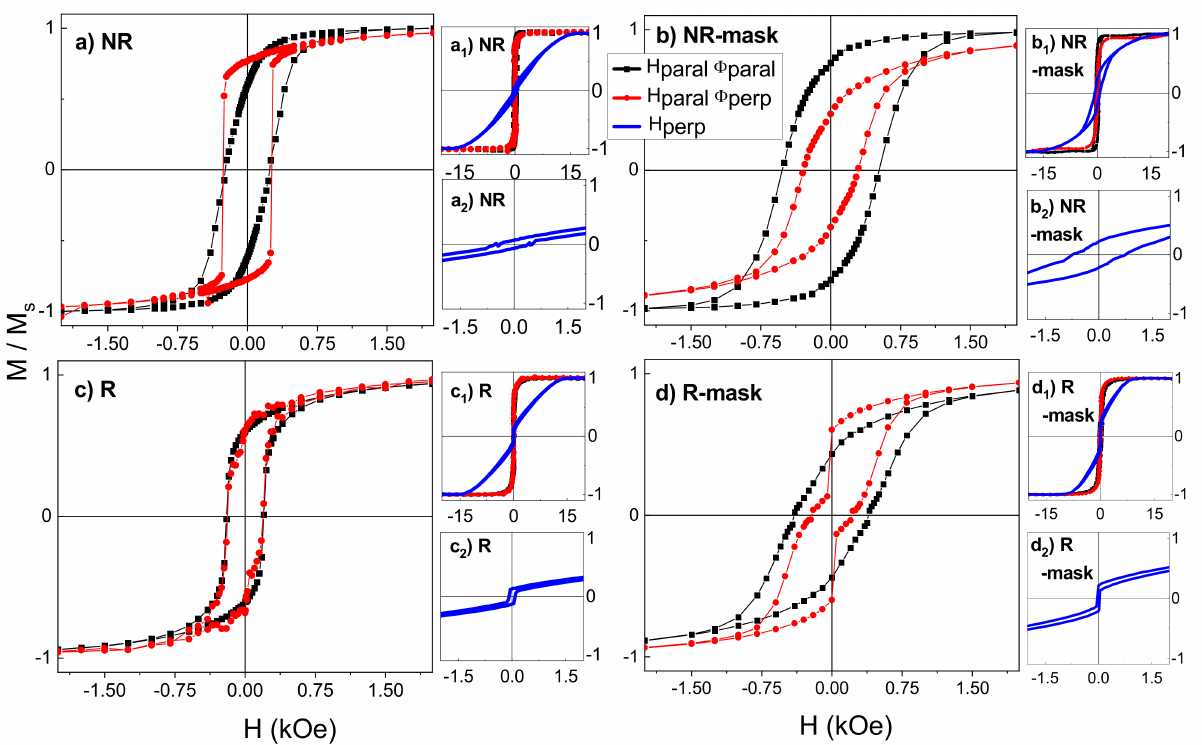
Figure 4. Normalized magnetization curves with the magnetic field applied parallel to the substrate surface (in-plane) and along the atomic flux projection direction ( H paral Φ paral ; black curves) and perpendicular to it ( H paral Φ perp ; red curves) for samples: ( a ) NR; ( b ) NR-mask; ( c ) R, and ( d ) R-mask. Normalized saturated magnetization curves measured in-plane sample surface and perpendicular to it for: ( a1 ) NR; ( b1 ) NR-mask; ( c1 ) R; and ( d1 ) R-mask. Zoom of magnetization curves with perpendicular field for: ( a2 ) NR; ( b2 ) NR-mask; ( c2 ) R; and ( d2 )